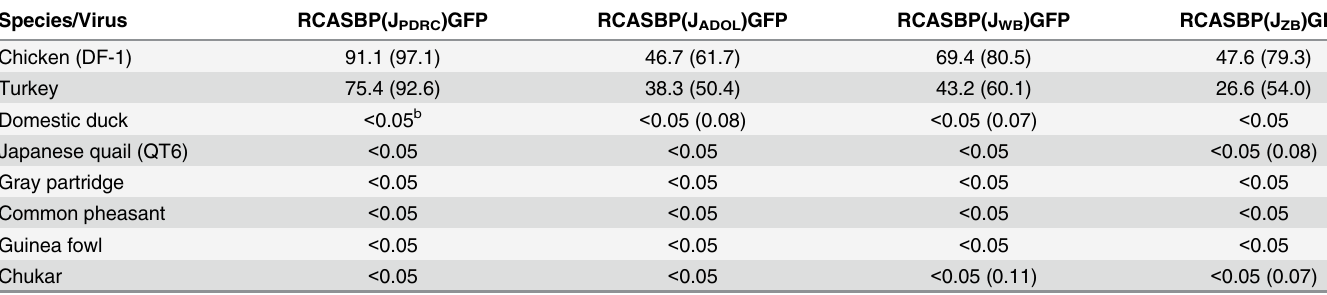
a The embryo fi broblasts of a given species, or DF-1 and QT6 cell lines, were infected with multiplicity of infection = 1. The percentage of GFP-positive cells two or four (in parentheses) days post infection are given as an average of two parallels.